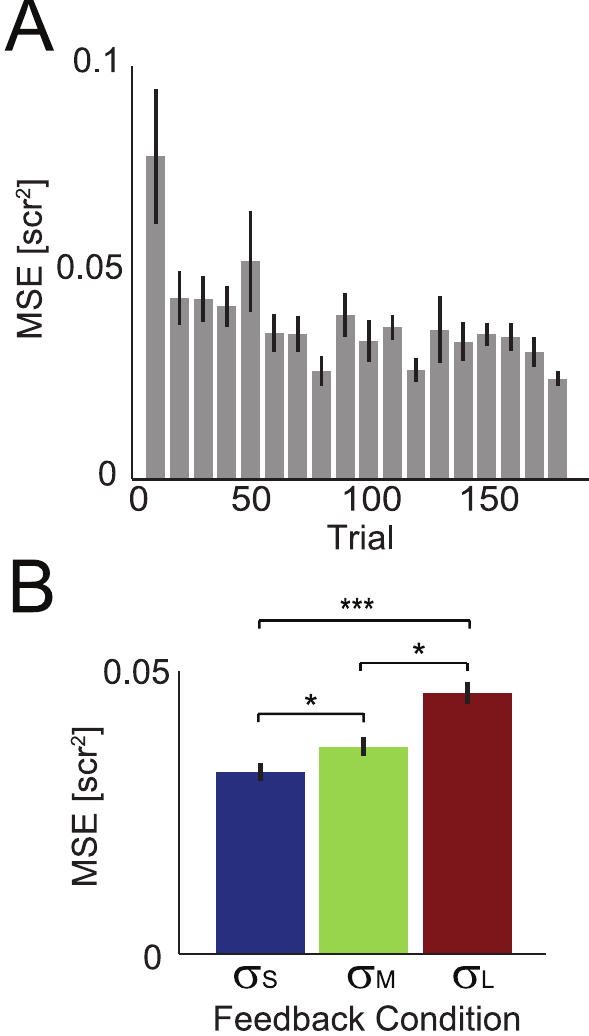
Figure 2. Task errors across time and across feedback conditions. A) Average errors across subjects over the course of the experiment binned in blocks of 10 trials. B) The influence of feedback type on task errors. All comparisons between feedback uncertainty levels were significant (one-sided t-test). In both plots errorbars denote SEM across 10 subjects. * denotes p , 0.05. *** denotes p , 0.001.